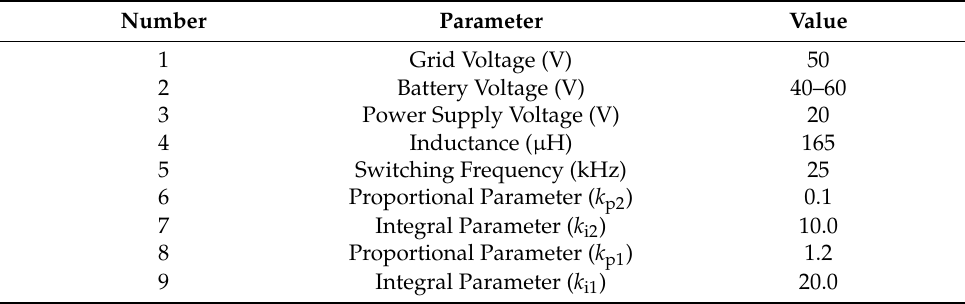
Figure 8. SIMULINK based simulation model. Table 2. Simulation parameters of main